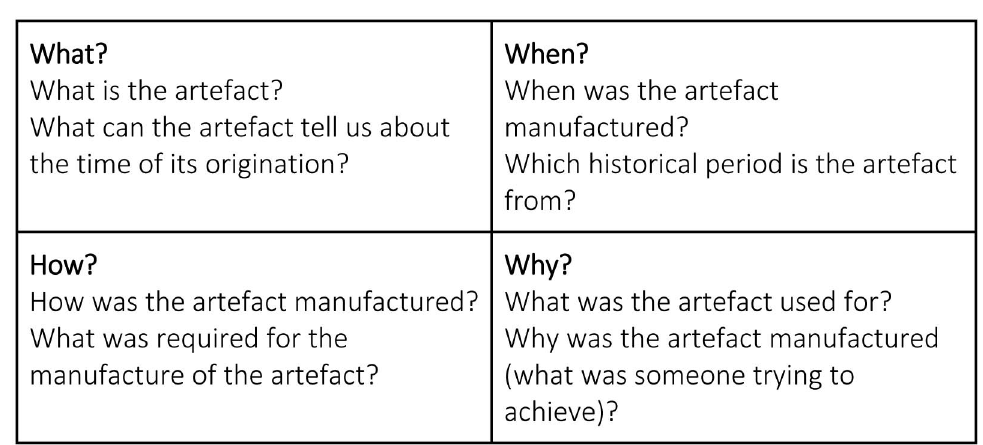
Figure 1: Template providing generic questions for the interpretation of archaeological